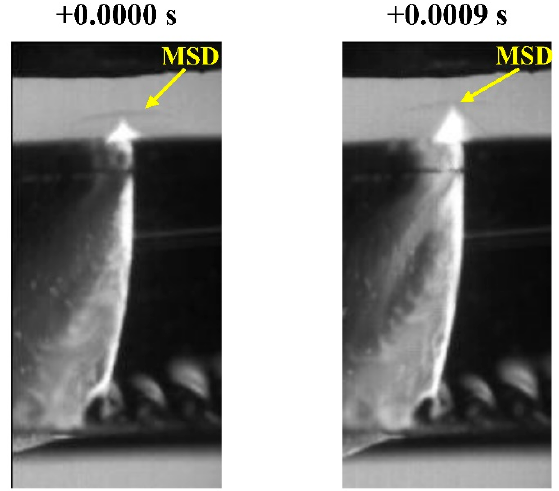
Figure 14. Displacement of the normal shock MSD due to the plume of ionized material emerging from the cut kerf (Processing conditions: Laser power P = 1400 W, cutting speed v c = 1000 mm/min, conical nozzle, nozzle diameter d = 2 mm, stand-off Z = 1.5 mm, assist gas: argon, supplying pressure p = 8 bar). Reprinted with permission [57]; Copyright 2011 IOP Publishing.